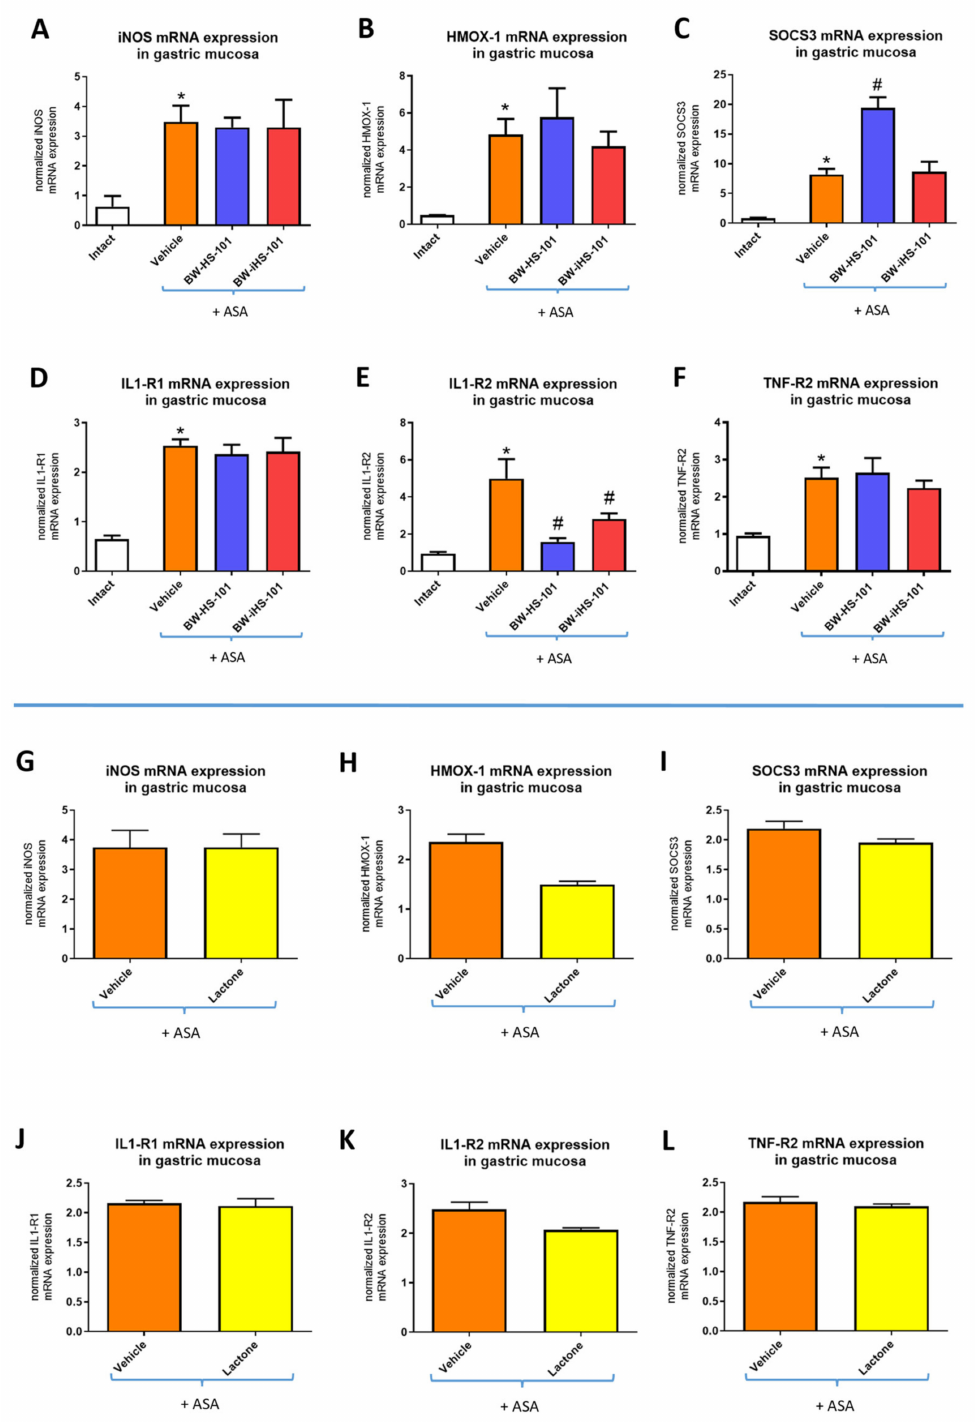
Figure 4. Gastric mucosal mRNA expression of inducible nitric oxide synthase (iNOS) ( A , G ), heme oxygenase (HMOX)-1 ( B , H ), suppressor of cytokine signaling 3 (SOCS3) ( C , I ), interleukin (IL) receptor (R)1 ( D , J ), IL-R2 ( E , K ), and tumor necrosis factor (TNF)-R2 ( F , L ) in rats administered i.g. with acetylsalicylic acid (ASA, 125 mg/kg) and pretreated 30 min earlier with vehicle, BW-HS-101 (50 µ mol/kg), BW-iHS-101 (50 µ mol/kg) or lactone (50 µ mol/kg). Results are mean ± SEM of five rats per each experimental group. Significant changes as compared with the respective values in intact rats are indicated by asterisk (*) ( p < 0.05). Hash (#) indicates significant changes as compared with vehicle ( p < 0.05). ( G – L ): Results were reported on separate figures because technically the data were calculated based on the different reference sample and the fold-change values for the same vehicle group are different than on panels ( A – F